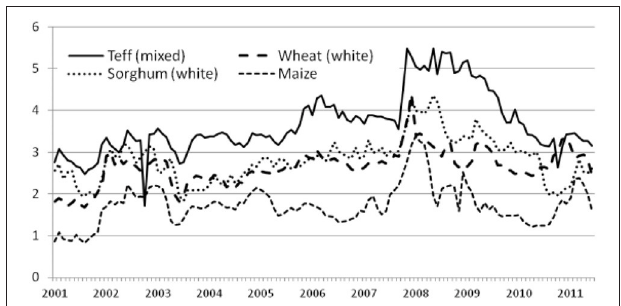
FIGURE 4 | A comparison of cereal prices in Addis, 2001-2011 compiled based on Ethiopian Grain Trade Enterprise (EGTE) wholesale prices (in ETB per kg) ( Minten et al., 2012).